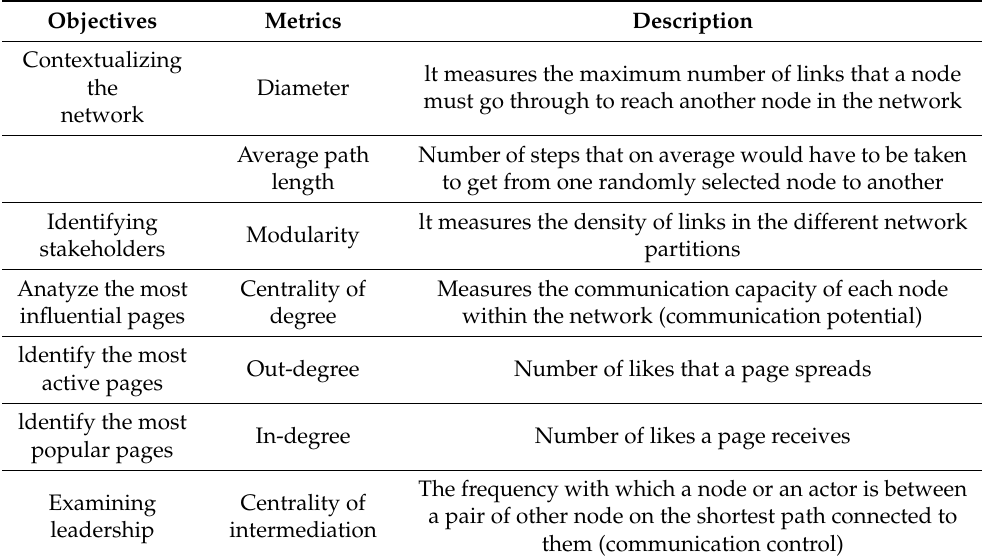
Table 2. SNA objectives and metrics